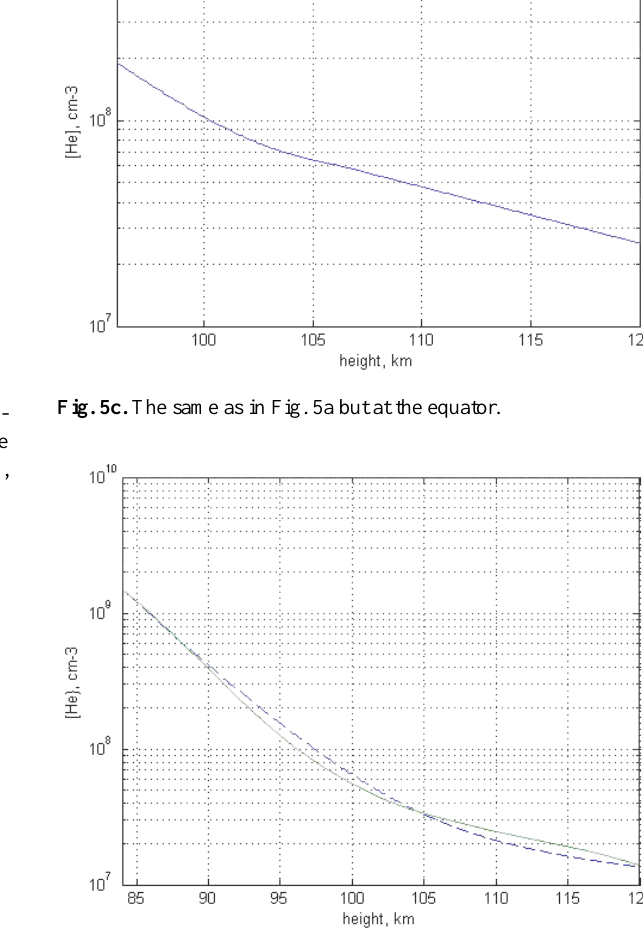
Fig. 5d. [He] height profile given by the MSIS-E-90 model in the polar region (solid line) and calculated by Eq. (4) with K m = ed